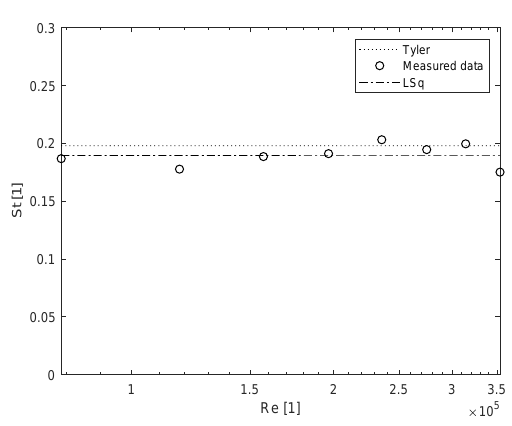
Fig. 8. Relation between Reynolds number and Strouhal number .